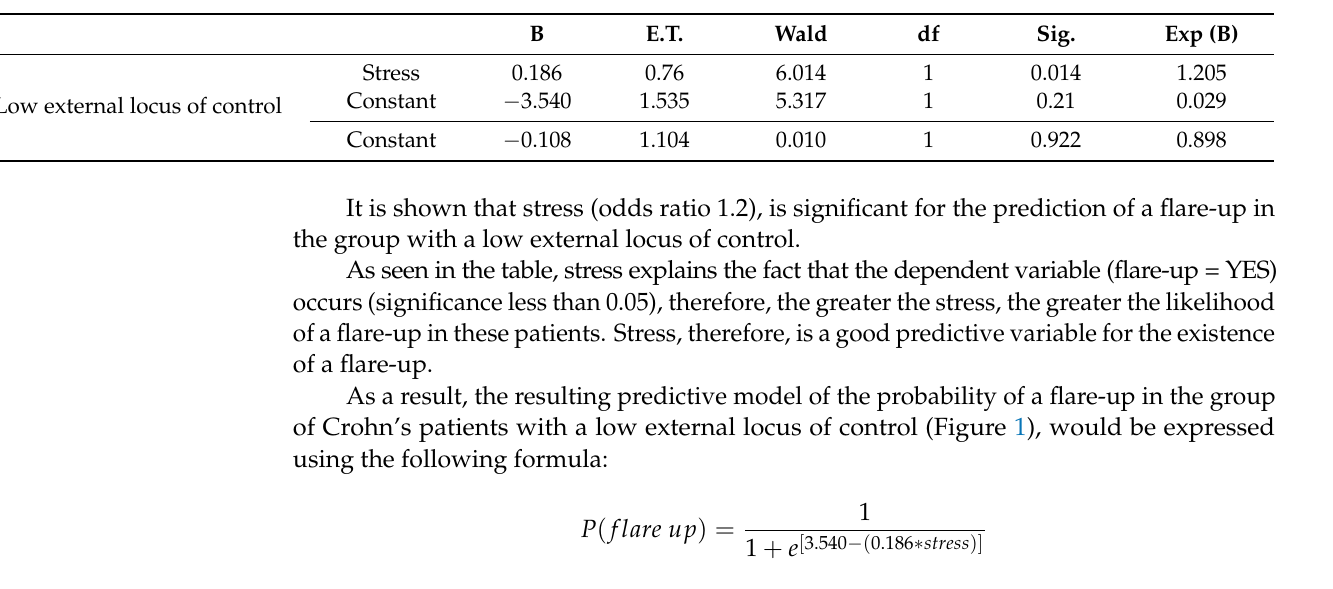
Table 6. Binary logistic regression model for flare-up